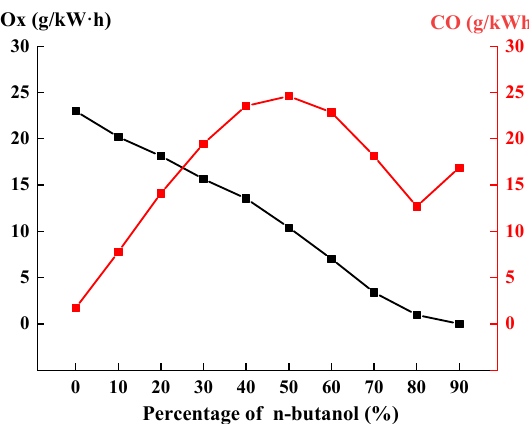
Figure 13. NOx and CO emissions with different n-butanol percentages.